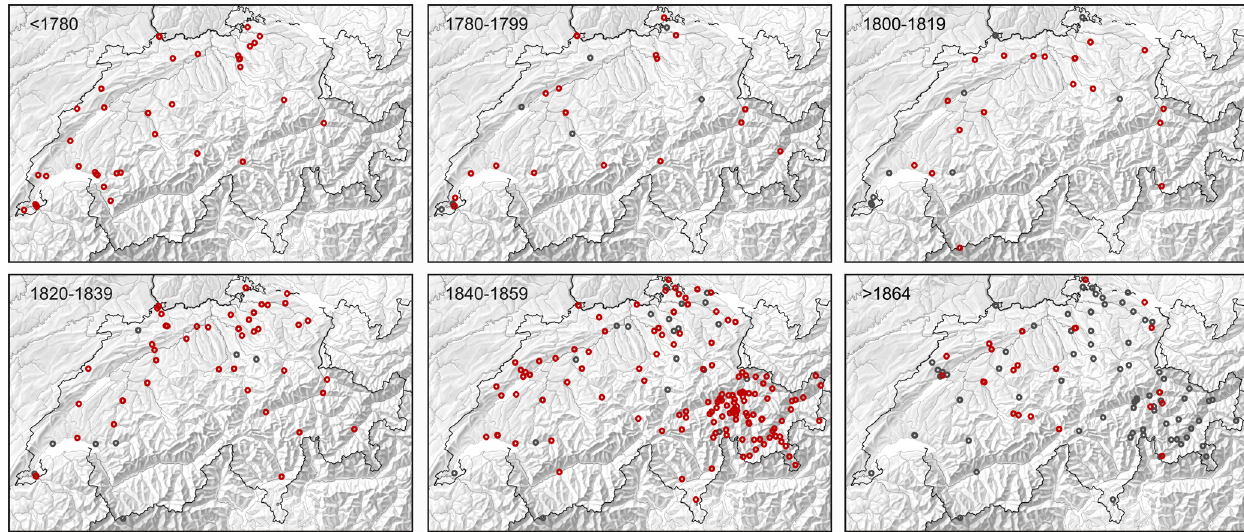
Figure 4. Maps of the available stations over time. Measurement series starting in the indicated period are shown as red dots, while grey dots represent stations with continuing observations.